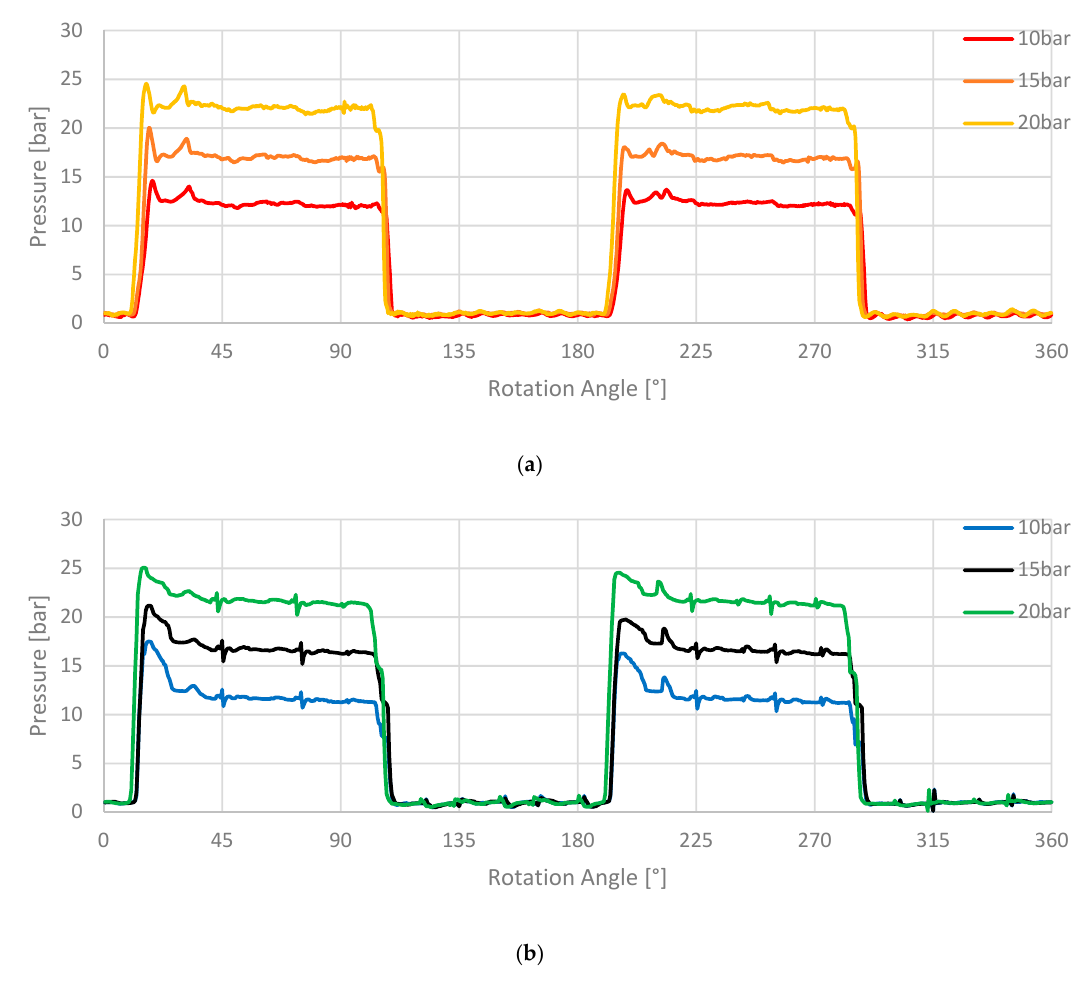
Figure 16. Effect of delivery pressure at a constant rotational speed of 2000 rpm on the displacement chamber pressure ( a ) measurement; ( b ) simulation.